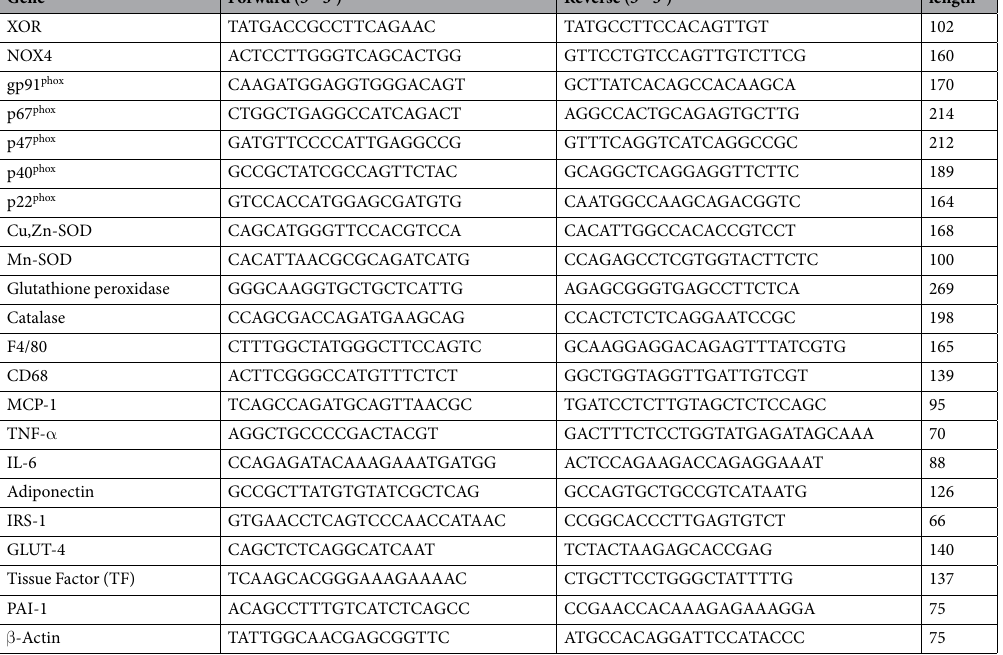
Table 1. Sequences of primers used for